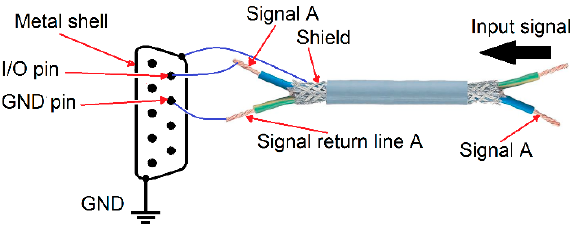
Figure 9. Shielding of signals sensitive to noise [33].